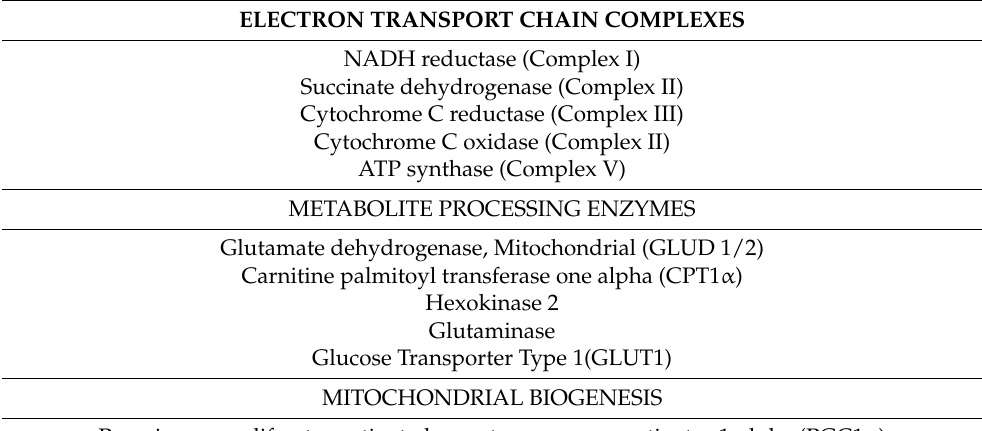
Table 2. List of mitochondrial metabolism proteins assessed by western blotting grouped in 3 sub- groups